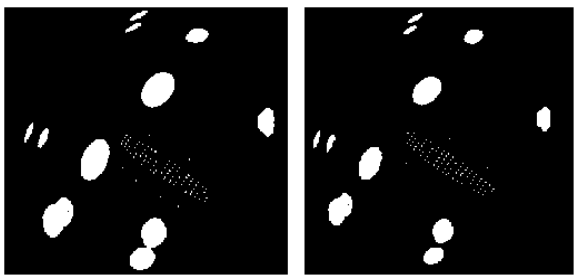
Figure 4. Camera station error ellipsoids for propeller in scale of 500 before (left) and after (right) omission of improper images In investigation of the car door (Opteka, 2004), 9 images were captured and after bundle adjustment procedure, the mean accuracy of x, y and z coordinates of the targets were determined. The standard deviation of exterior orientation values of each station are shown in Table 4. Moreover, the fuzzy computation system was tested on each station and the results are also shown in Table 4. In Table 4, three maximum exterior orientation standard deviation values and three minimum fuzzy values are highlighted with the color of chromatic gray and also three minimum exterior orientation standard deviation values and three maximum fuzzy values are highlighted with the color of pallid gray.